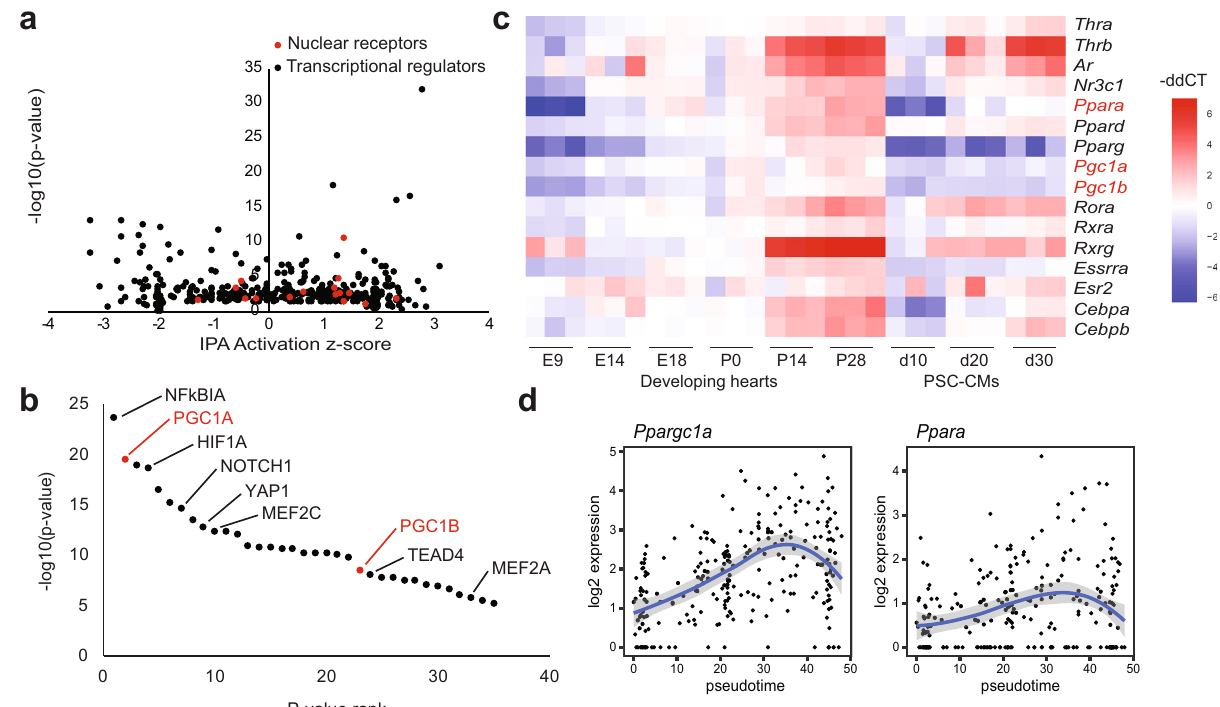
Fig. 2 PGC1/PPAR is a predicted key upstream regulator of CM maturation. a Top transcriptional regulators plotted by p-value and IPA activation z-score with nuclear receptors highlighted in red. b P -value ranking of top upstream regulators of CM maturation with two PGC1 isoforms highlighted in red. c Heatmap of gene expression of PGC1 and nuclear receptors in developing mouse hearts and cultured PSC-CMs, quanti fi ed by qPCR. d Expression trends over pseudotime of PGC1 and PPAR α in postnatal CMs. Error bands represent a 95% con fi dence